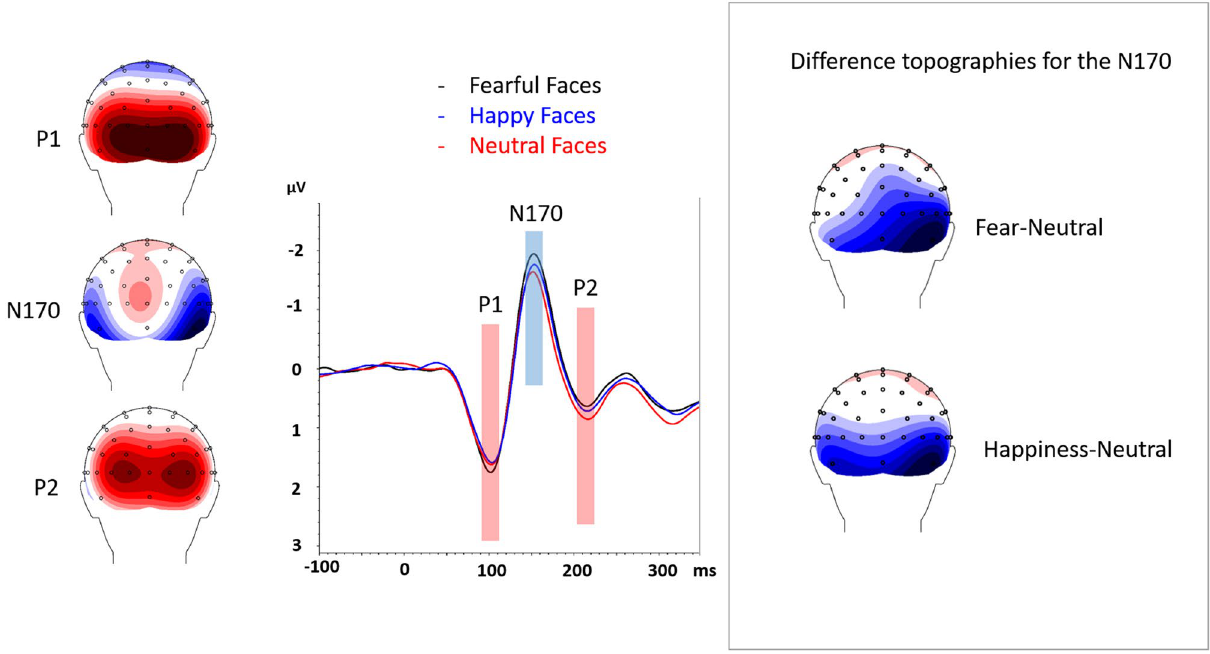
Figure 1. The N170 is shown for fearful faces (black) and neutral faces (red) conditions. Left and right leads are collapsed. On the right, difference topographies are shown for fearful minus neutral conditions and for happy minus neutral conditions at the